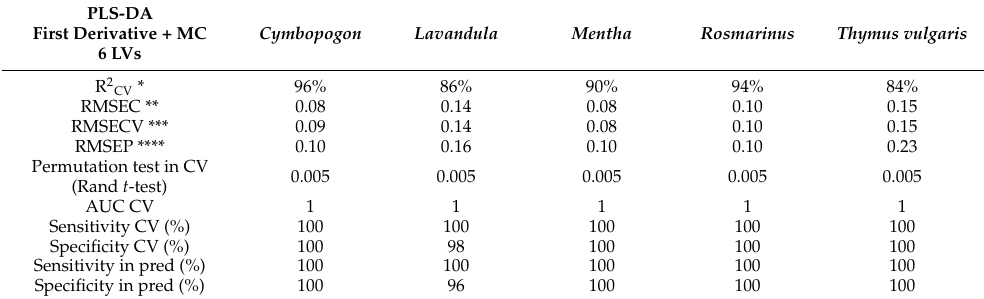
Table 6. PLS-DA results for the whole EOs